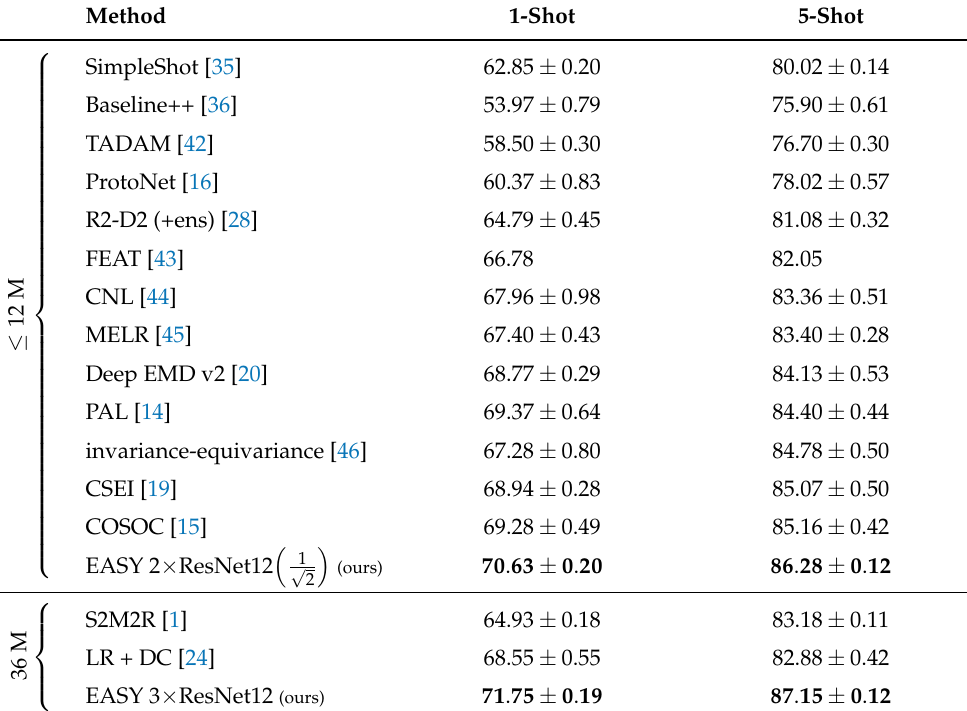
Table 1. The 1-shot and 5-shot accuracy of state-of-the-art methods and the proposed solution on MiniImageNet in the inductive